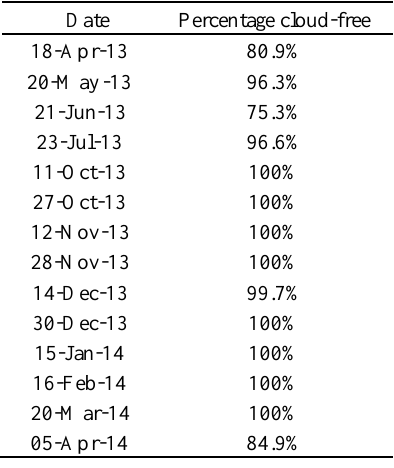
Table 1. Summary of the 14 Landsat OLI images used.